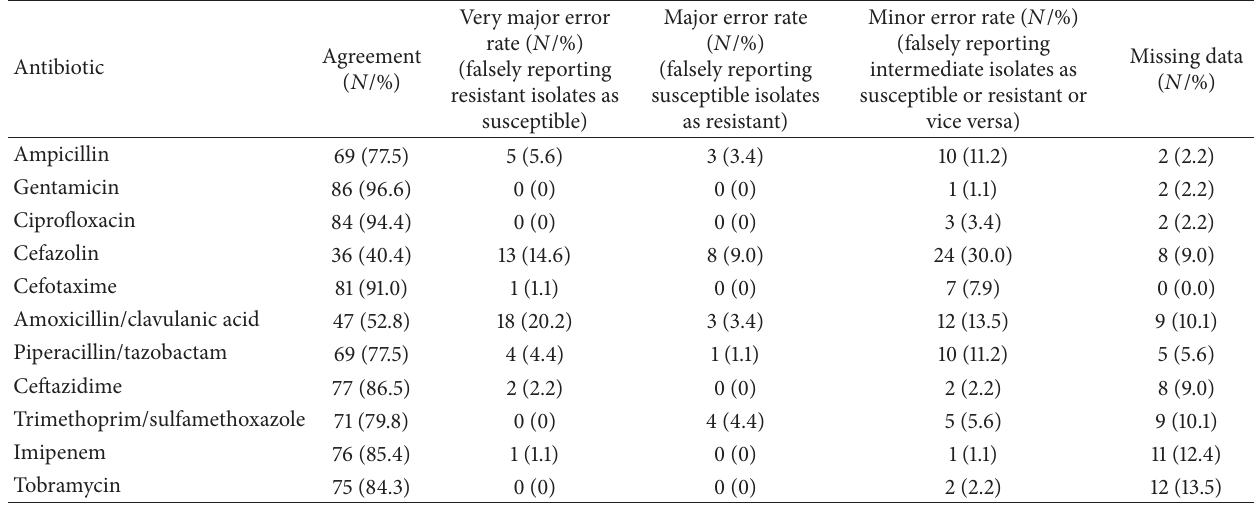
Table 2: Agreement between direct and standard susceptibility.